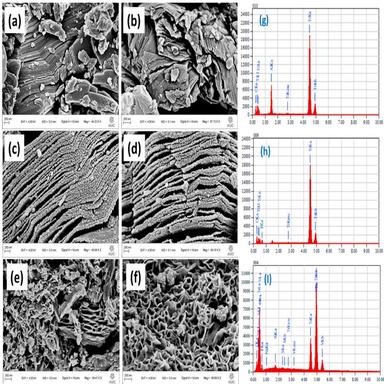
Low and high magnification FESEM images of (a–b) MAX powder, (c–d) MXene, and (e–f) GVO/MX, (g–i) EDX spectra of MAX, MXene and GVO/MX.